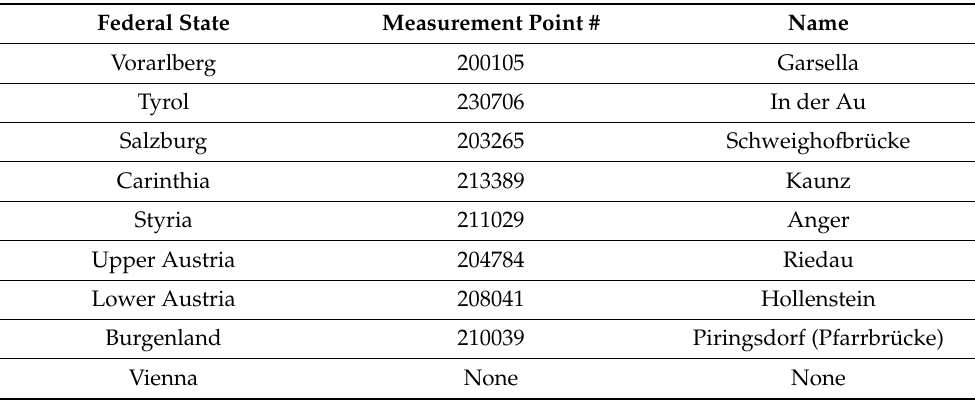
Table A2. Measurement points used for small hydropower plant SLP